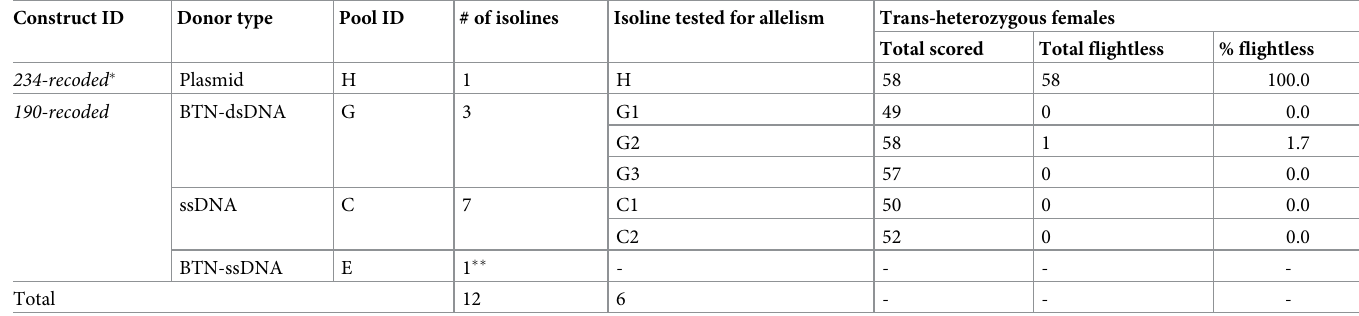
Table 1. Isolines established from G 1 individuals and scoring of flight ability of trans-heterozygous females to test for allelism to AeAct4 hdr1 .